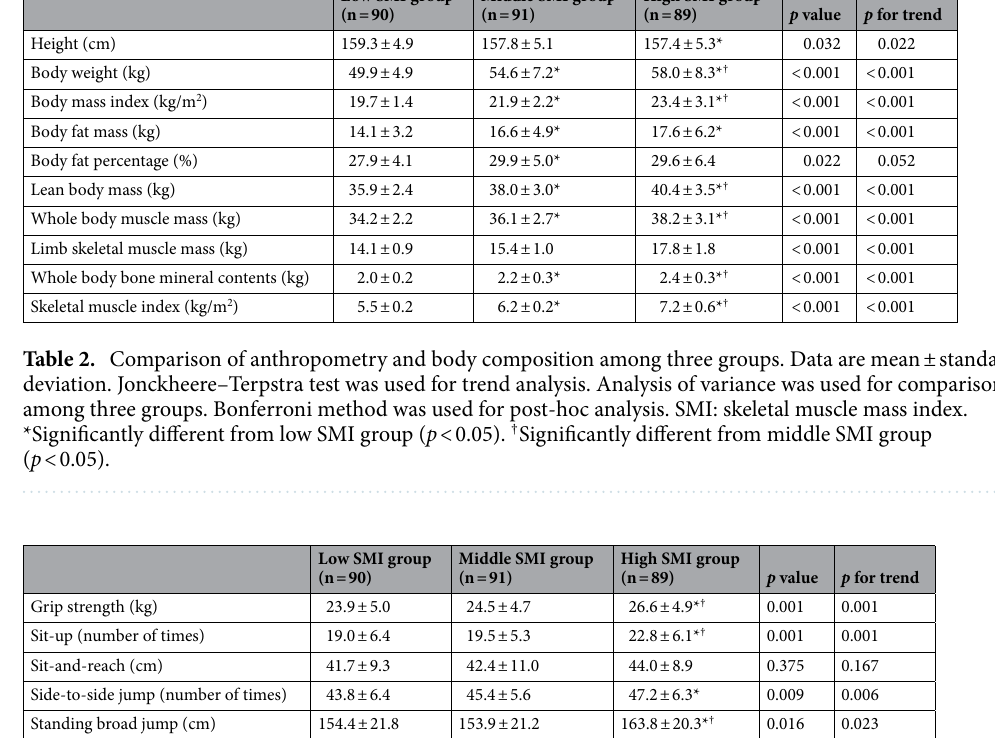
Table 3. Results of physical fitness tests in three groups. Data are mean ± standard deviation. Jonckheere– Terpstra test was used for trend analysis. Analysis of variance was used for comparison among three groups, and Bonferroni method was used for post-hoc test. SMI: skeletal muscle mass index. *Significantly different from low SMI group ( p < 0.05). † Significantly different from middle SMI group ( p < 0.05).